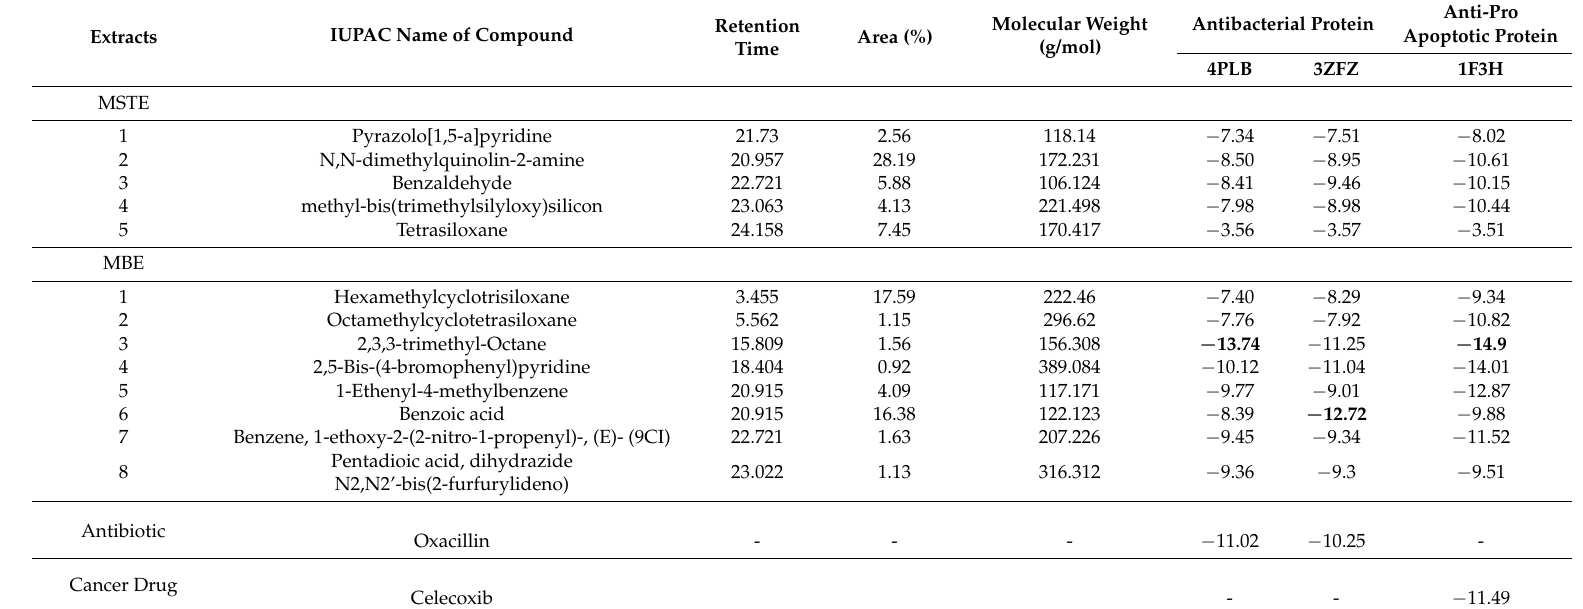
Table 1. Analysis of alkaloids and low molecular weight molecules from the methanolic extract of bark (MBE) and stem (MSTE) of T. vernicifluum by gas chromatography–mass spectrometry (GC-MS) and their molecular instructions with antibacterial activity and anti-proapoptotic related proteins. The bold values indicate a higher docking score than other